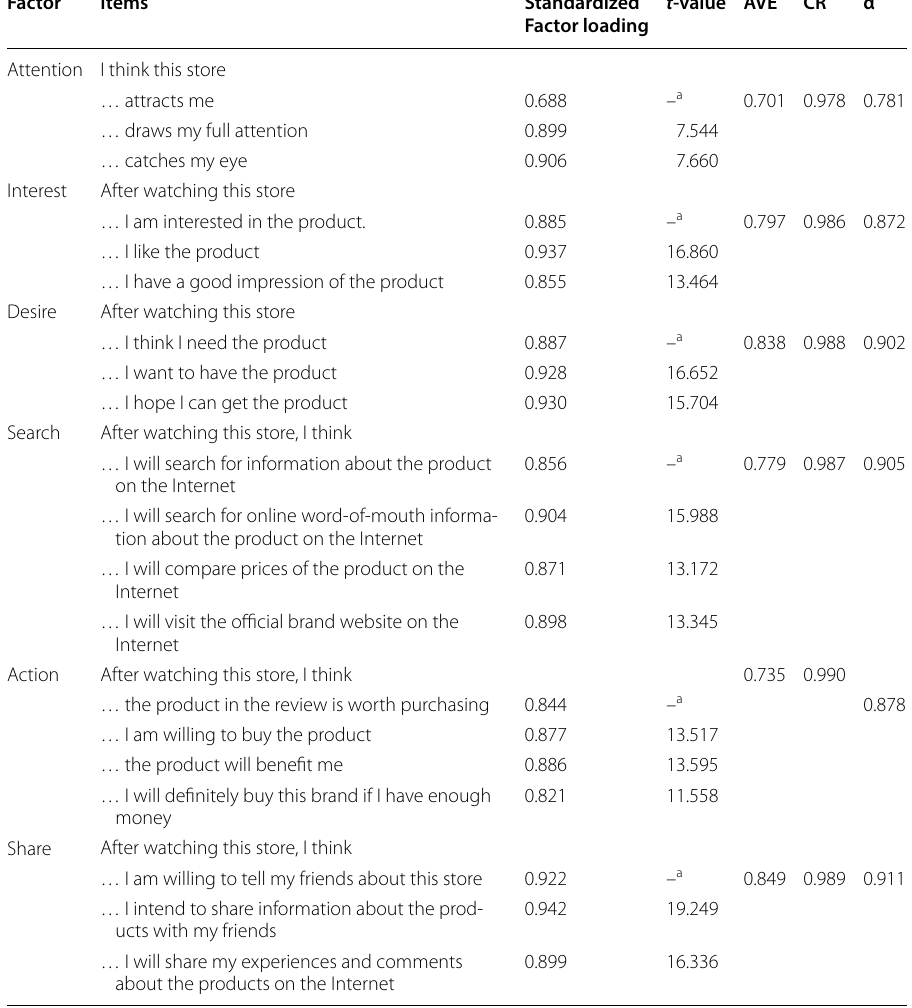
Table 2 Results of the confirmatory factor analysis